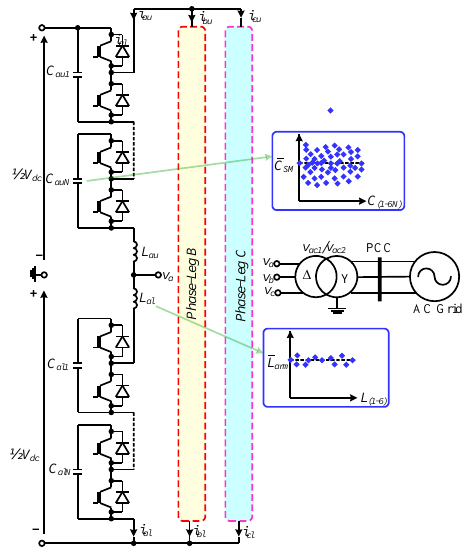
Figure 1. Modular multilevel converter (MMC) topology configuration.